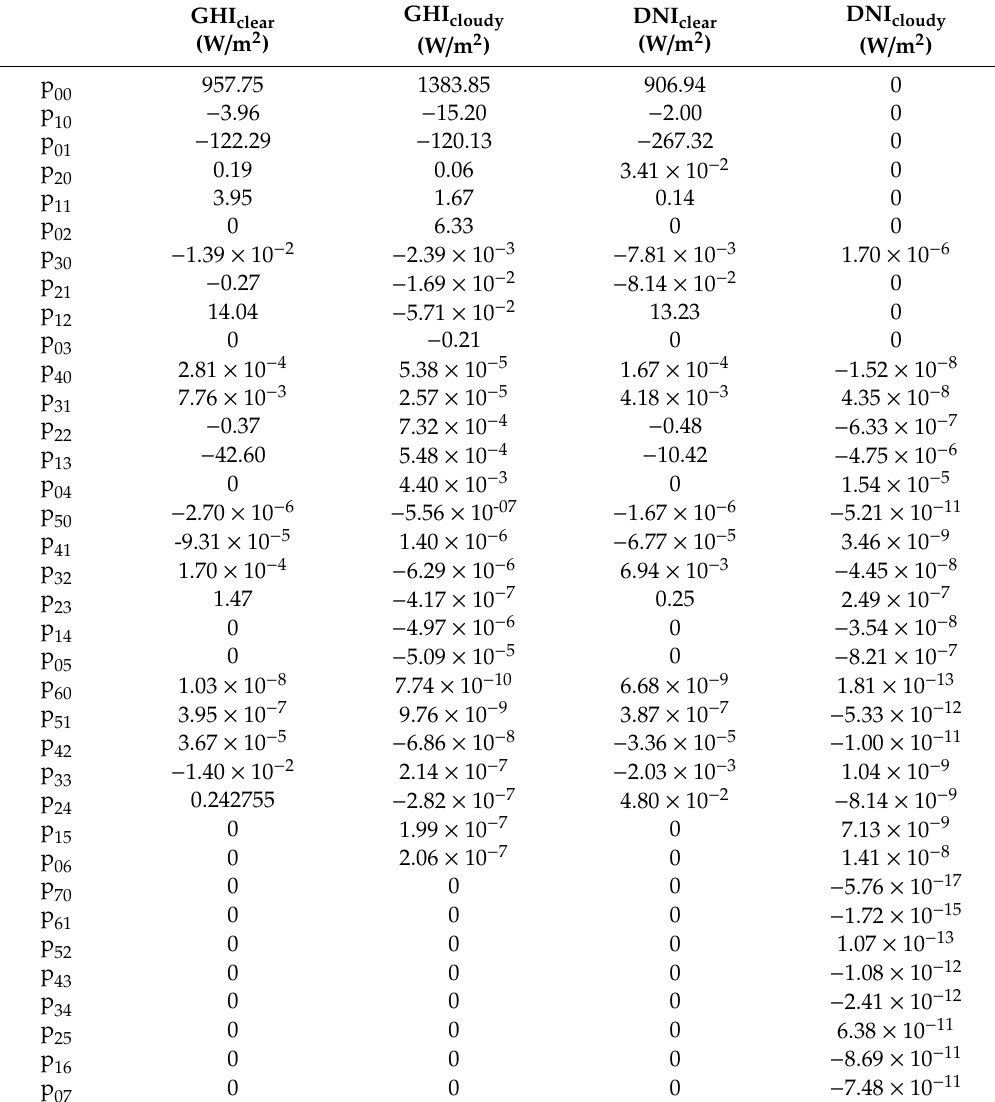
Table 2. Values of coe ffi cient used for the polynomial function in Equation (1) of INSIOS model for GHI and DNI estimation under clear-sky and cloudy